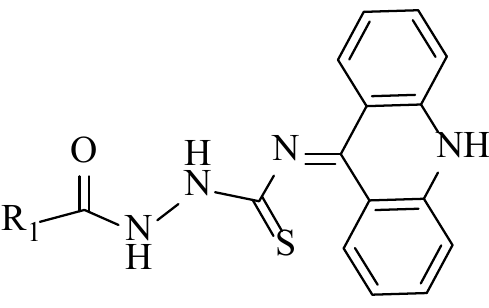
Figure 5. Reported structure of acridine thiosemicarbazides [13].